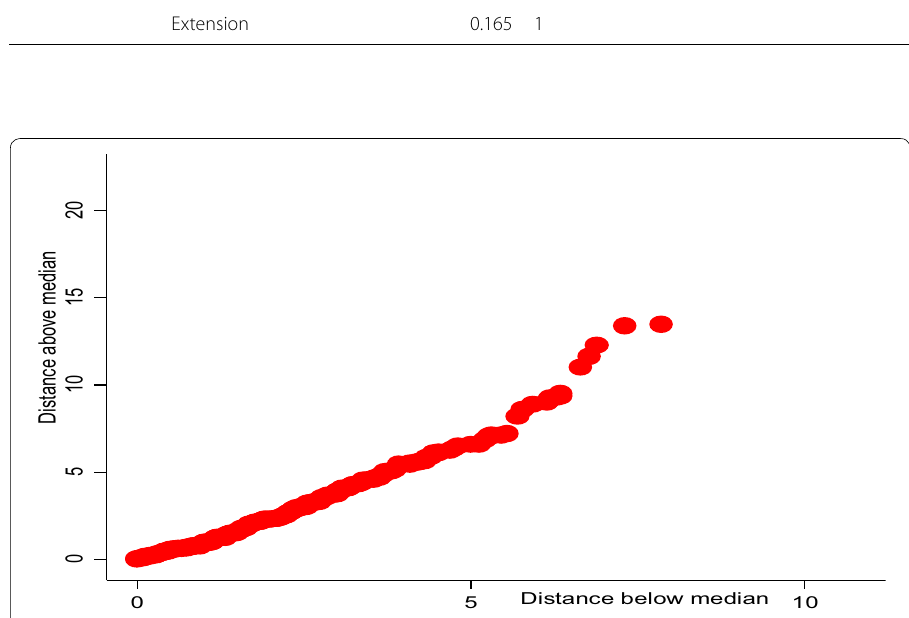
Fig. 5 Normal probability plot (NPP) test for red pepper market